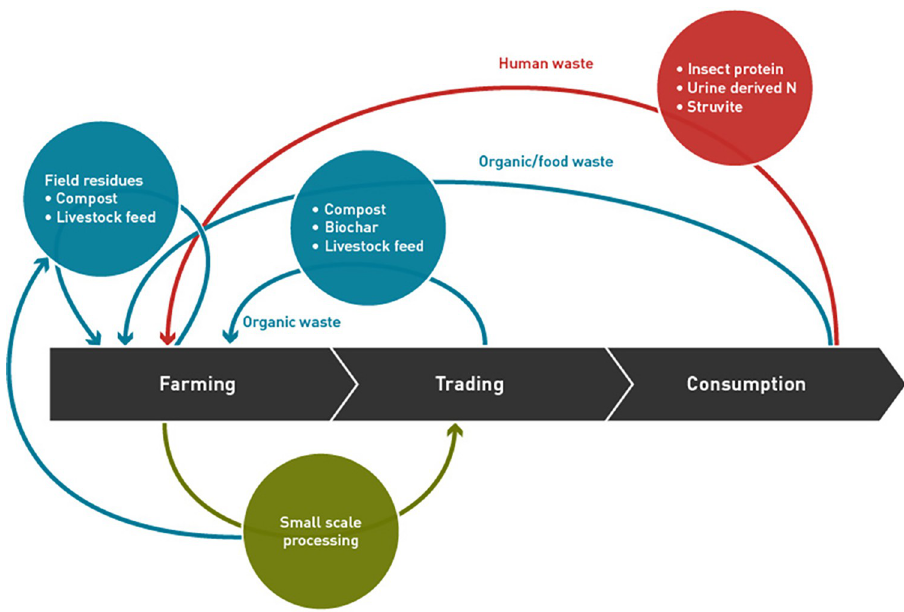
Fig 1. The envisioned circular bioeconomy (CBE) to be established through CBE innovations co-designed and co- implemented by RUNRES.